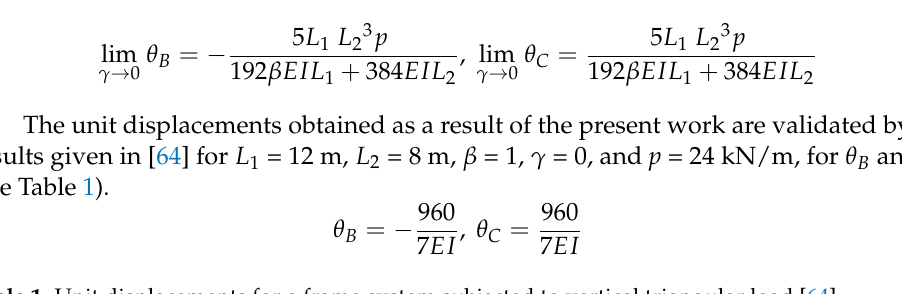
Table 1. Unit displacements for a frame system subjected to vertical triangular load [64]. Unit Displacements Reference Study ( γ / L = 0) [64] Present ( γ / L = 0) θ B − 960 θ C 960 Special Case: Variable cross section.